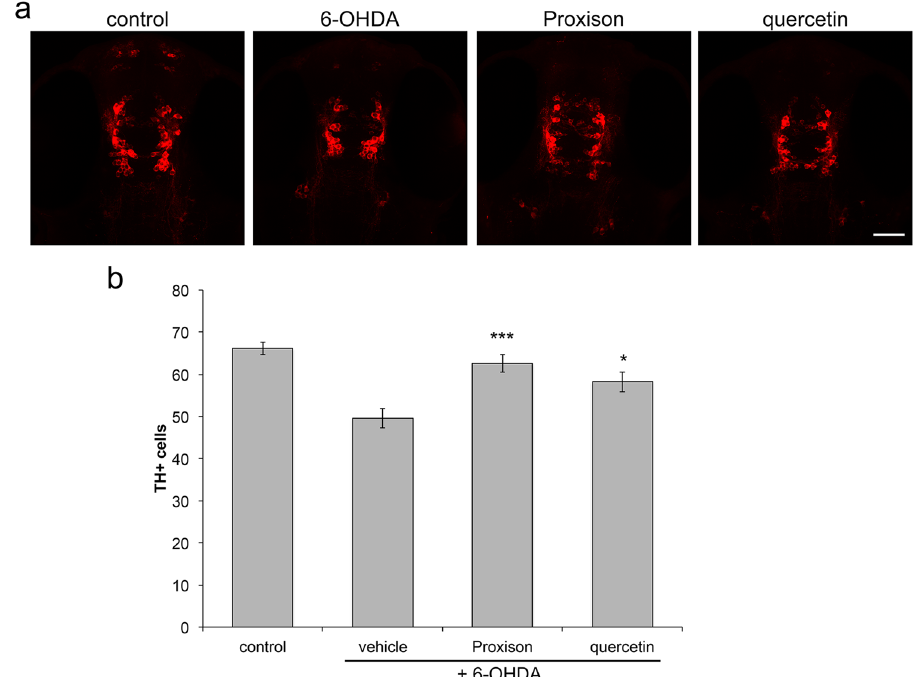
Figure 6. Antioxidant protection against 6-OHDA-induced dopaminergic cell death in zebrafish embryos. ( a ) Zebrafish embryos at 24 hours post-fertilisation (hpf) were treated with 6-OHDA for 24 hours in the presence or absence of the antioxidants Proxison or quercetin (10 μ M). Embryos were then fixed at 48 hpf, immunostained for TH (red) and confocal images were taken of the embryo head viewed from the top. Scale bar: 50 μ m. ( b ) The number of TH-positive cells in each embryo was counted for each treatment group (control, n = 28; vehicle, n = 30; Proxison, n = 26, quercetin, n = 24). Bars represent the mean number of TH-positive cells and error bars show the SEM. ANOVA with Tukey’s post-hoc test was performed to assess the significant difference to the 6-OHDA treated embryos; * p < 0.05, *** p <